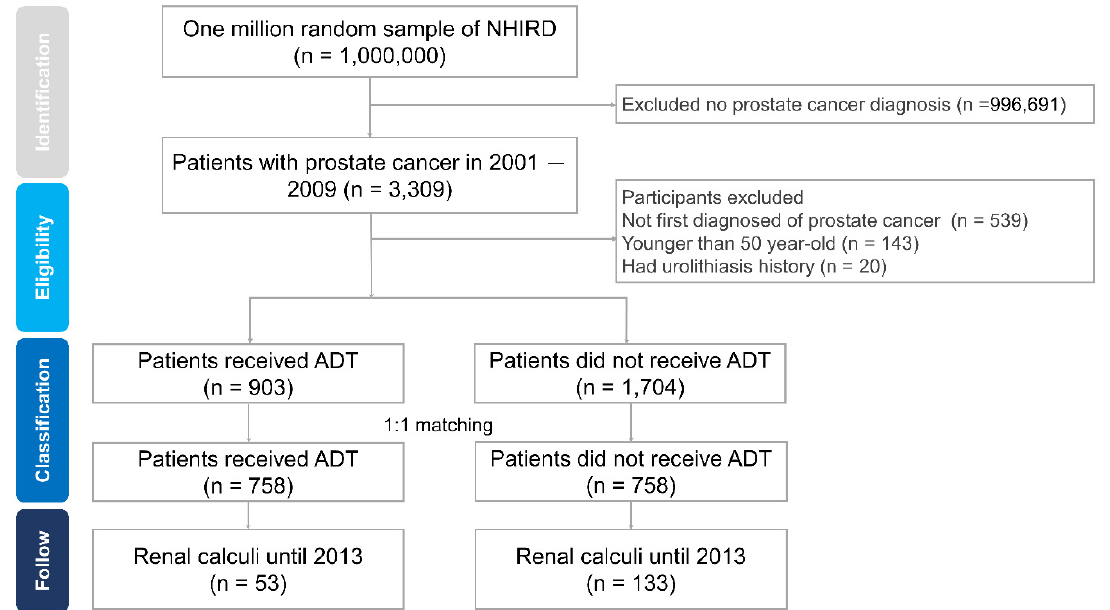
Figure 1. Study flowchart of cohort selection. ADT: androgen deprivation therapy; NHIRD: National Health Insurance Research Database.